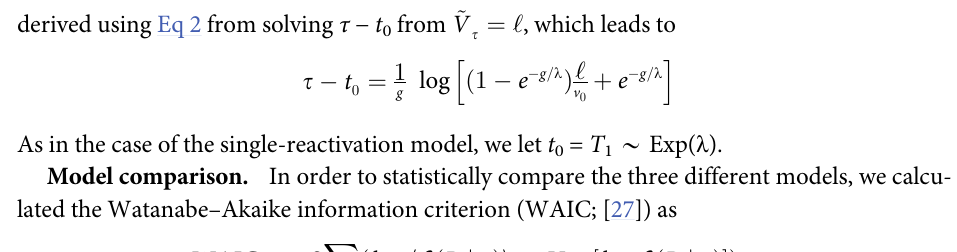
S1 Fig. Model fits, used data points and posterior predicted rebound time distributions for all macaques. The panels (DPI: days post infection) show the VL data (black dots connected by black lines, with red dots for left-censored observations; the grey dots are ignored) taken from all 25 macaques for whom rebound was observed, and the stochastic multiple-reactiva- tion model prediction (blue lines: posterior mean; dark blue band: 50% credible interval (CrI), light blue band: 50% posterior predictive interval). The estimated time-to-rebound ( τ ) is given by the vertical black line. The density plots in the background indicate the posterior predictive distribution of τ . The green distributions are conditioned on the estimated time of the initial recrudescence event, the purple distributions are unconditional. S2 Fig. Marginal posterior densities of the first recrudescence times. Marginal densities of (red) for each macaque are estimated with our multiple-reac- T 1 (blue) and the extrapolated ^ T 1 tivation model. The numbers on top indicate the time of ART initiation. S3 Fig. Comparison between simulated rebound times and an alternative approximation for the time-to-rebound distribution. In this case, the law of V is approximated with a t Gamma distribution with mean κ ( t ) and variance κ ( t ). The simulated empirical distributions 1 2 are shown in color, and our approximation is shown in black. The predicted PDF (A) is calcu- lated with numerical differentiation. (B) The survival function (i.e. the fraction of subjects S ( t ) that do not have a detectable VL at time t ) is defined by Eq S5 in S1 Text. For the top, middle, and bottom panels different values of λ are used ( λ = 5 d − 1 , 1 d − 1 , and 0.2 d − 1 respectively). Notice the different time scale on the horizontal axes. For the remaining parameters, we